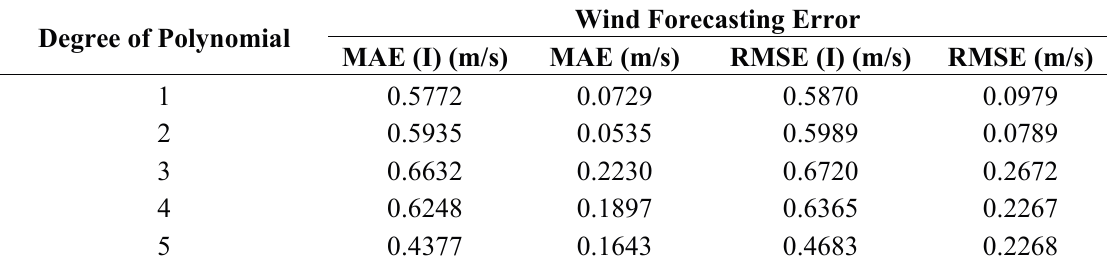
Table 3. MAE and RMSE results of wind speed prediction in February